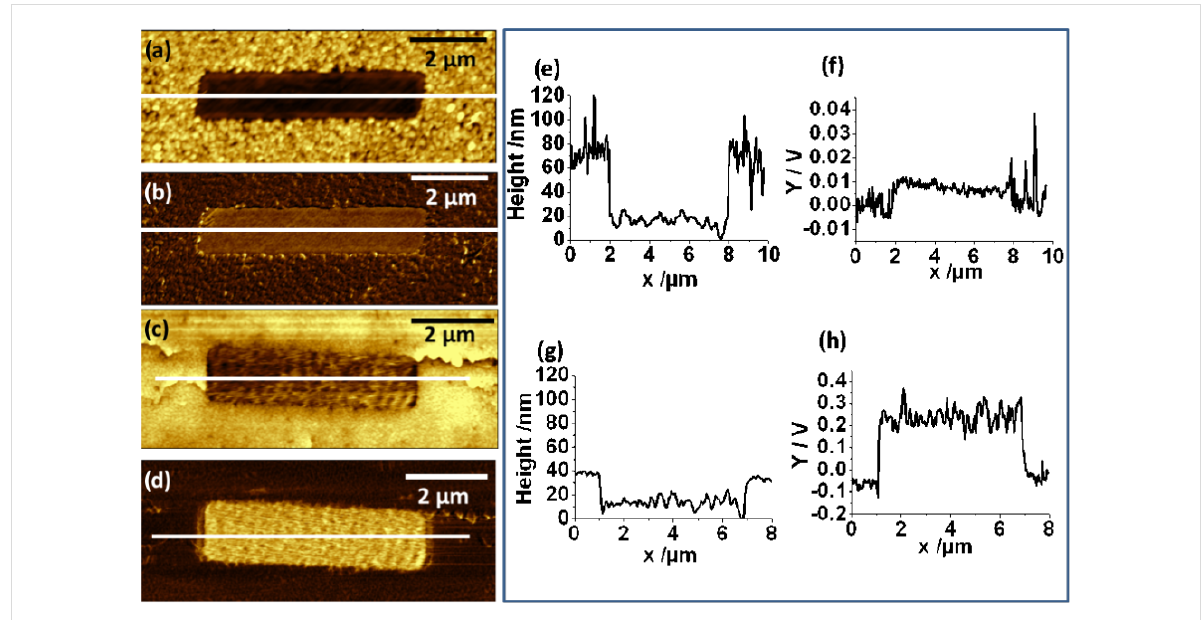
Figure 9: AFM images of Cu electrodeposition onto a MBP0/Au/Si sample demonstrating the quality of passivation of the cross-linked MBP0-SAM. Topography (a,c) and friction (b,d) images of the Cu structure as deposited (a,b) and after transfer to epoxy glue (c,d); (e) height and (f) friction profile along the line for Cu as deposited; (g,h) corresponding profile for the lifted-off structure. The 5 × 1 μ m 2 rectangle of cross-linked MBP0-SAM was generated with an electron beam dose of 500 mC/cm 2 . Conditions for the two-step electrodeposition were − 0.7 V for 1s and − 0.35 V for 10